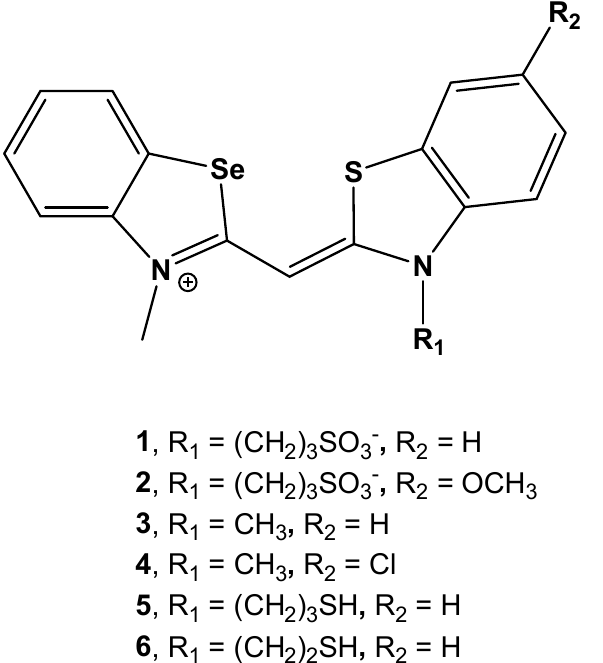
Figure 1. Structures of monomethine cyanine dyes 1–6 with benzoselenazolyl unit [23].